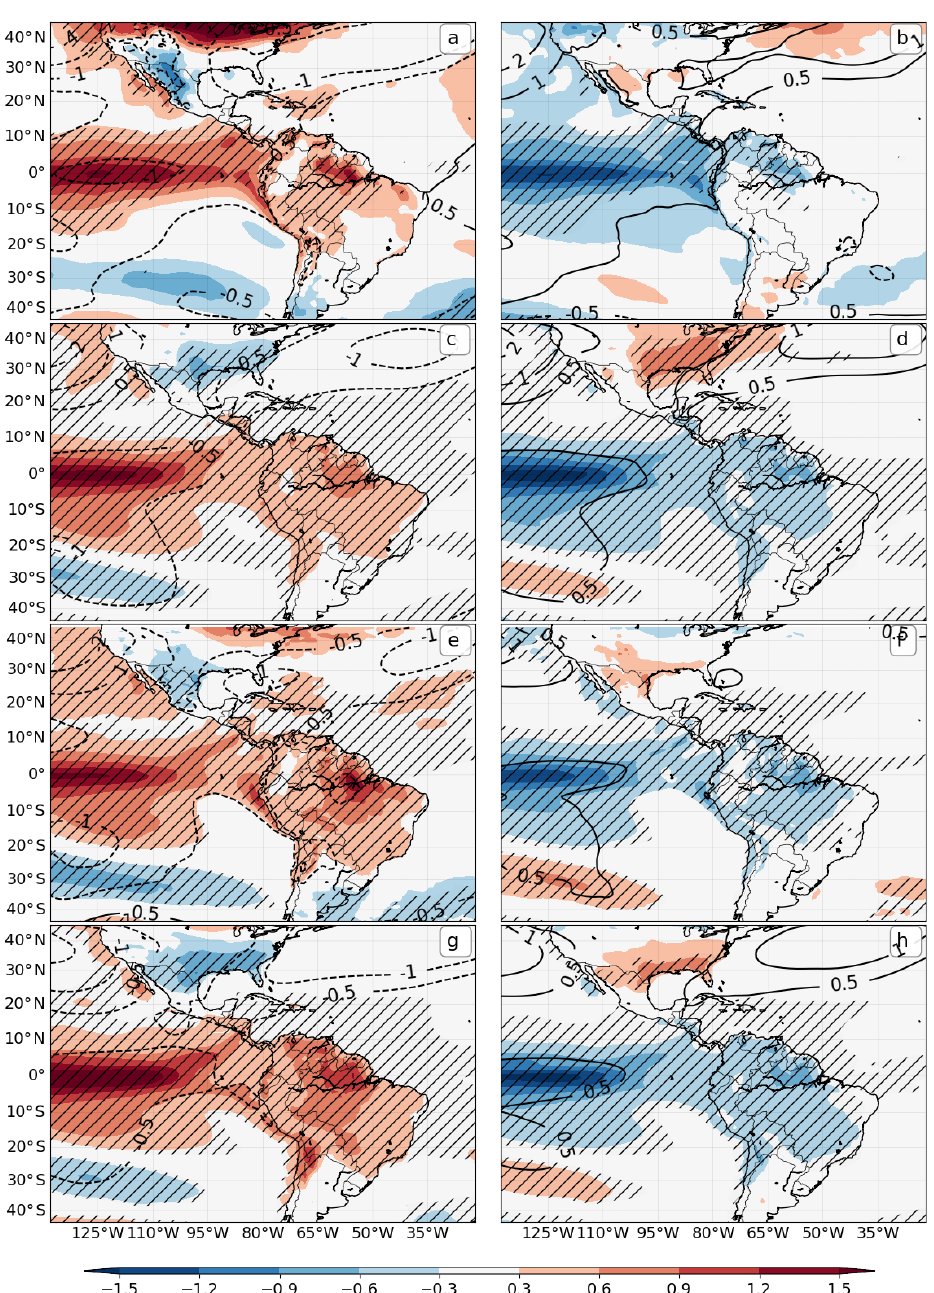
Figure 10. DJF temperature anomalies (colour contours in kelvin) and SLP (line contours in hectopascals) during (a, c, e, g) El Niño and (b, d, f, h) La Niña events. Results are shown for (a, b) ERA5, (c, d) UKESM1-historical, (e, f) GC3 N96-pi and (g, h) GC3 N216-pi. The hatched regions denote 99% significance from a Welch t test for the temperature